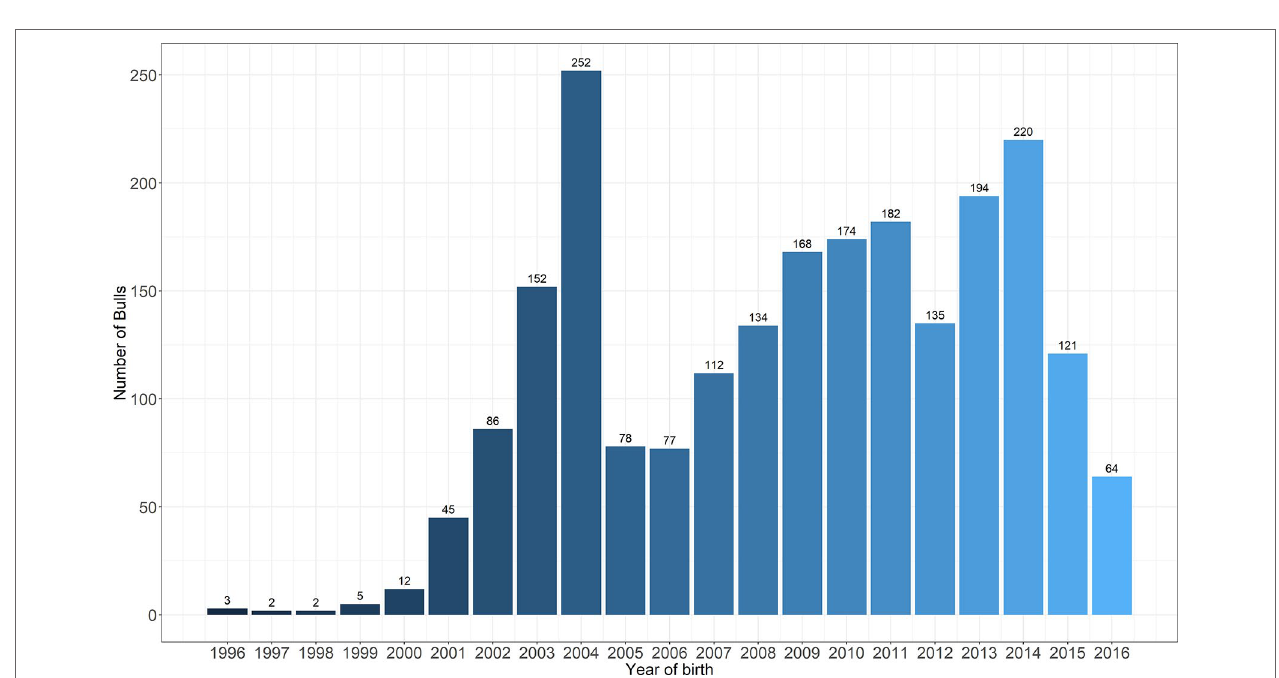
FIGURe 2 | The distribution of bulls across the years of